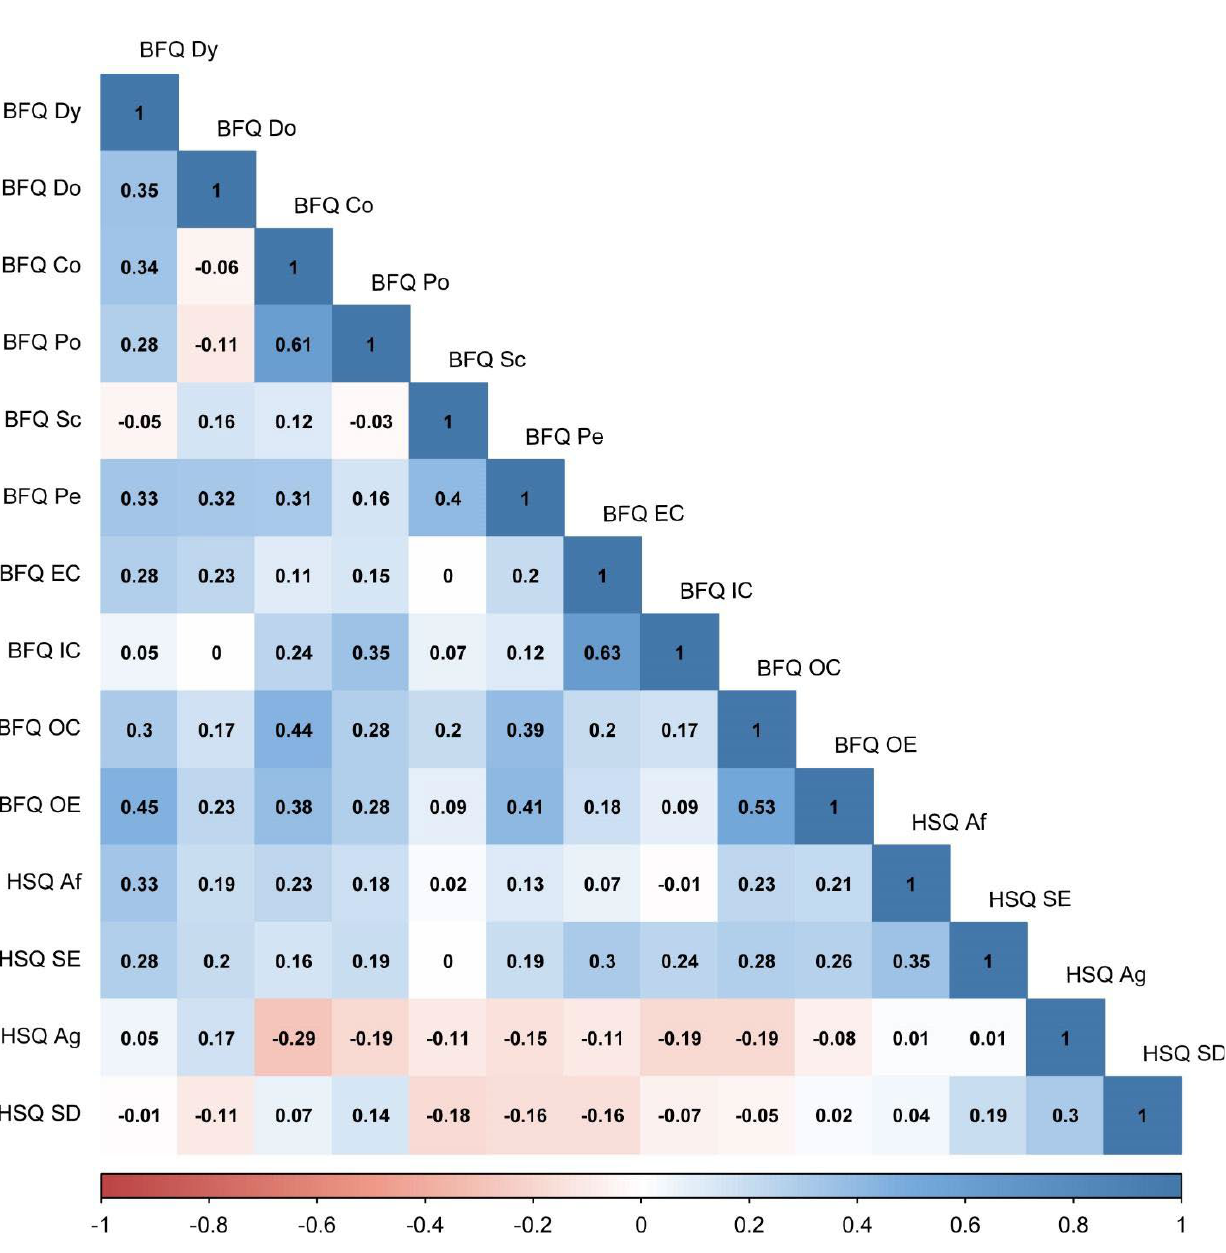
Figure 1. Zero order Pearson correlations ( n = 462). Note: Big Five Questionnaire (BFQ) ten facets. Dy: Dynamism; Do: Dominance; Co: Cooperativeness; Po: Politeness; Sc: Scrupulousness; Pe: Perseverance; EC: Emotion Control; IC: Impulse Control; OC: Openness to Culture; OE: Openness to Experiences. Humor Style Questionnaire (HSQ) four dimensions. Af: Affiliative; SE: Self-enhancing; Ag: Aggressive; SD: Self-defeating.